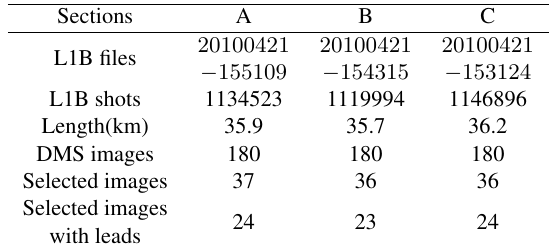
level reference obtained from the manual selection method are chosen as the opital threshold over the same profile; for these se- lected images without any leads or with too few leads, the SSH is estimated by linear interpolation derived from sea level heights on DMS image areas with leads (Wang et al., 2013). The lo- cal instantaneous sea surface height obtained from the optimal threshold method of ATM L1B data is then used as the local sea surface reference, snow freeboard equals ATM L1B elevation on snow surface (or ice) minus it.